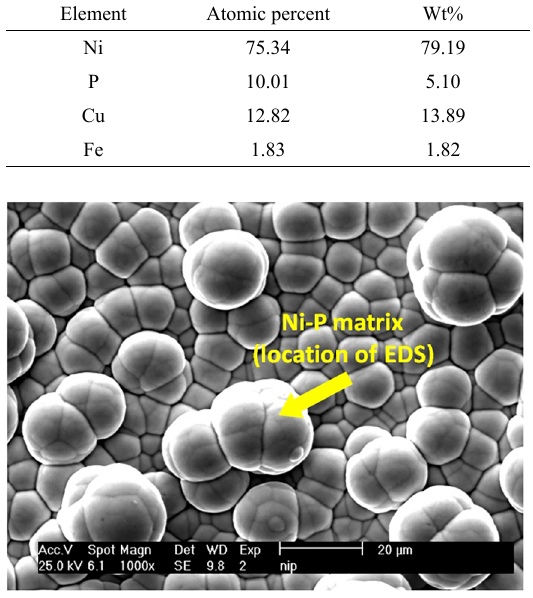
Figure 1. SEM micrograph of Ni-P coating. The location of EDS testing is defined by arrow. Note that there is no Cu in this coating.